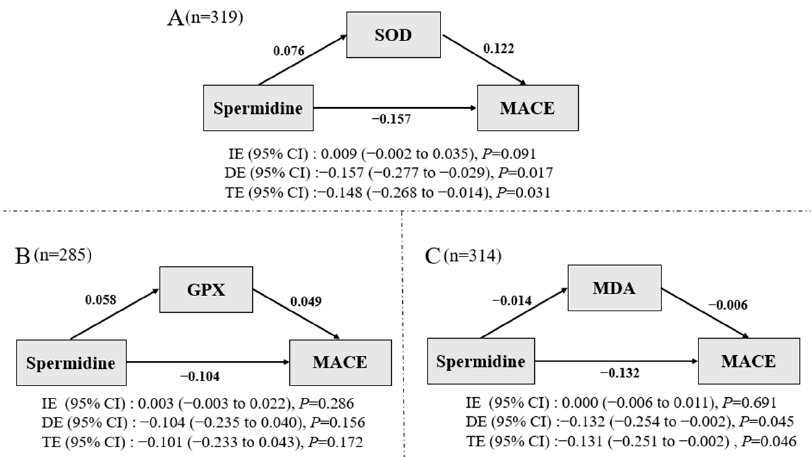
Figure 3. ( A – C ) Mediation effect of SOD ( n = 319), and GPX ( n = 285), MDA ( n = 314) on the MACE association. CI: confidence interval, SOD: superoxide dismutase, MDA: Malondialdehyde,